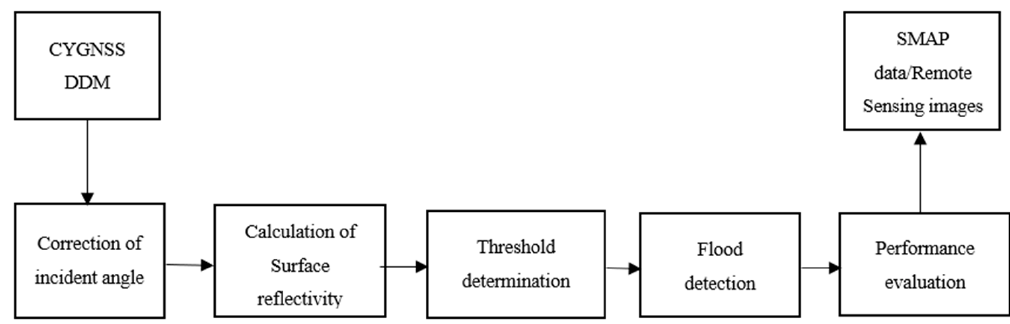
Figure 9. A simple flowchart of GNSS-R based flood detection.